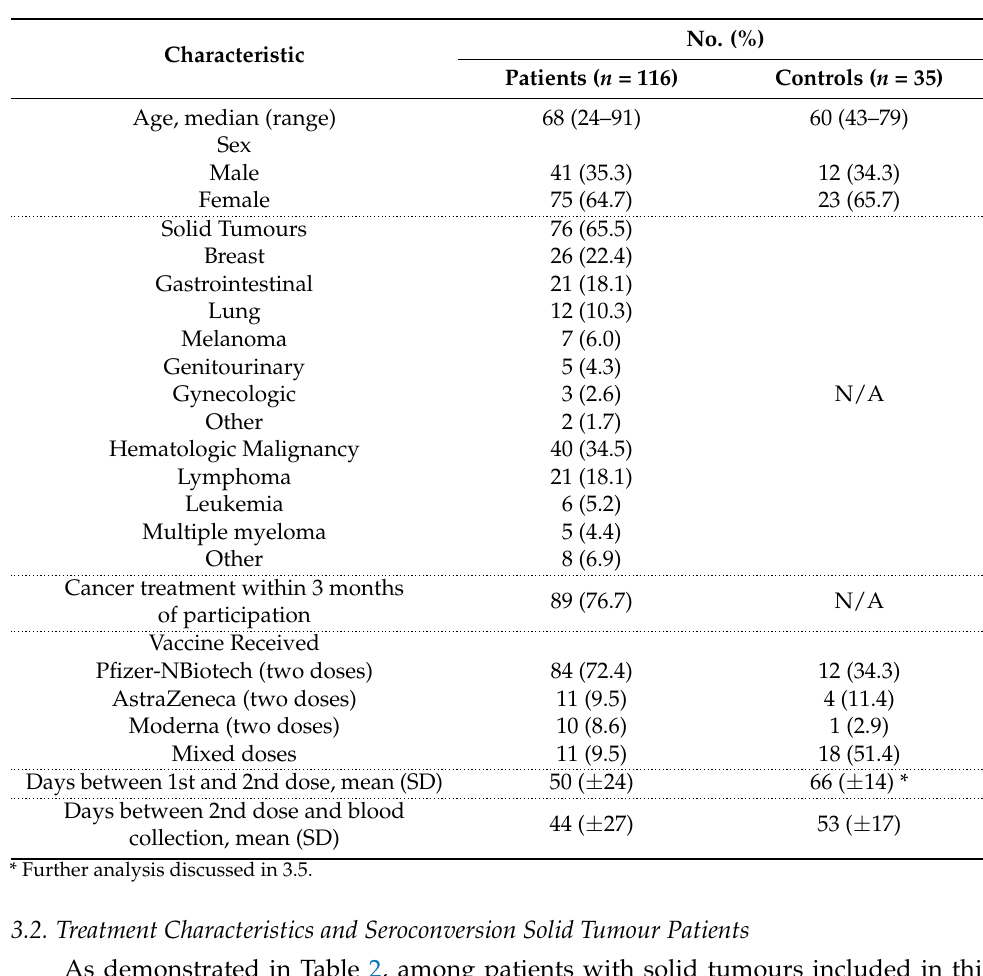
Table 1. Baseline Characteristics of Study